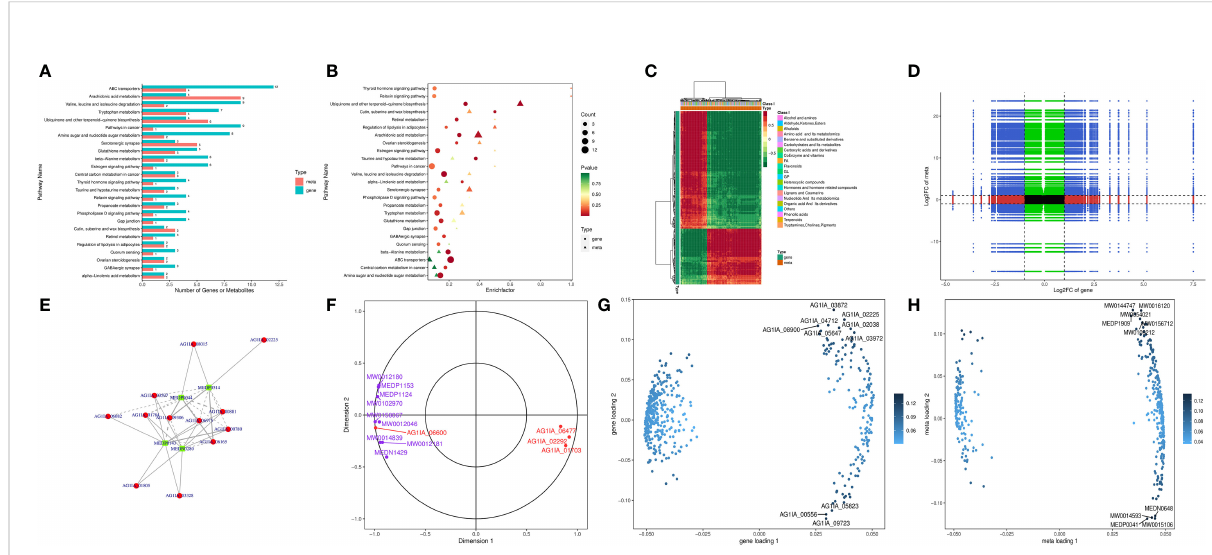
FIGURE 6 The antifungal molecular mechanisms of the antifungal compound PCN as revealed by the transcriptome and metabolome combined analysis. (A) bar graph of KEGG pathway enrichment analysis; (B) bubble chart of KEGG pathway enrichment analysis; (C) heatmap analysis; (D) nine- quadrant diagram of correlation analysis; (E) correlation network of differential genes and metabolites; (F) canonical correlation analysis (CCA); (G) gene loadings plot; (H) metabolite loadings